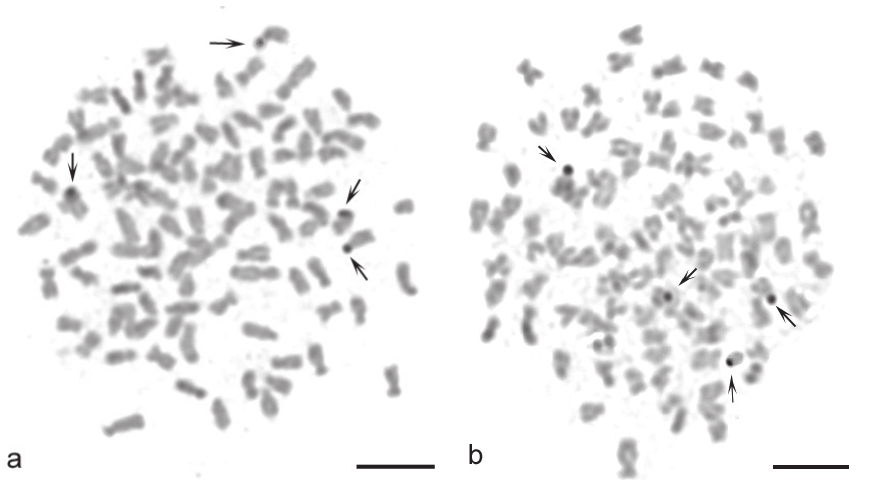
Figure 3. a–b AgNOR staining metaphases of C . carassius female ( a, b black arrows) indicate 4 NOR- positive sites. Bar = 10 μm.